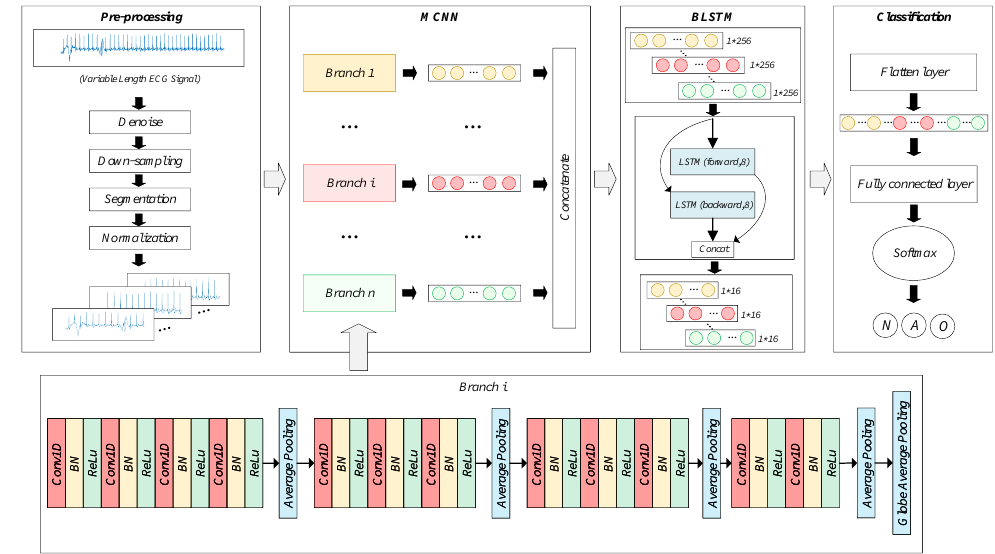
Figure 1. The architecture of the proposed model